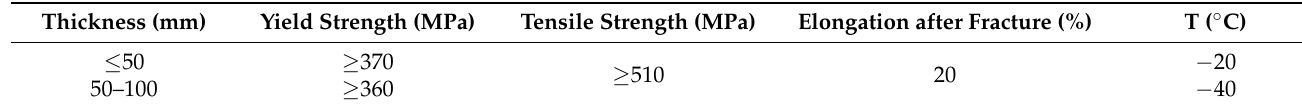
Table 2. The mechanical properties of